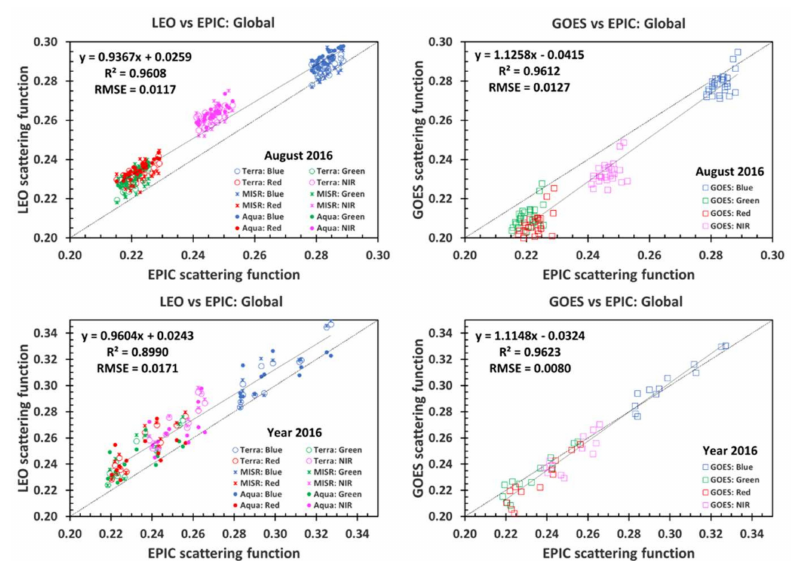
Figure 8. Correlation between Earth Orbiting Satellites (EOS) and EPIC scattering functions at blue (443 nm), green (551 nm), red (680 nm) and NIR (780 nm) spectral bands. Upper (lower) panels show daily (monthly) averaged scattering functions over LEO ( left ) and GOES ( right ) sampling areas.